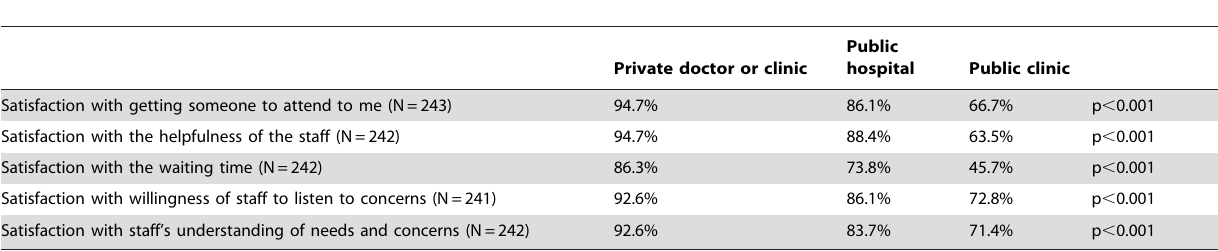
Table 3. Comparison of satisfaction ratings by type of healthcare service provider (spell out).